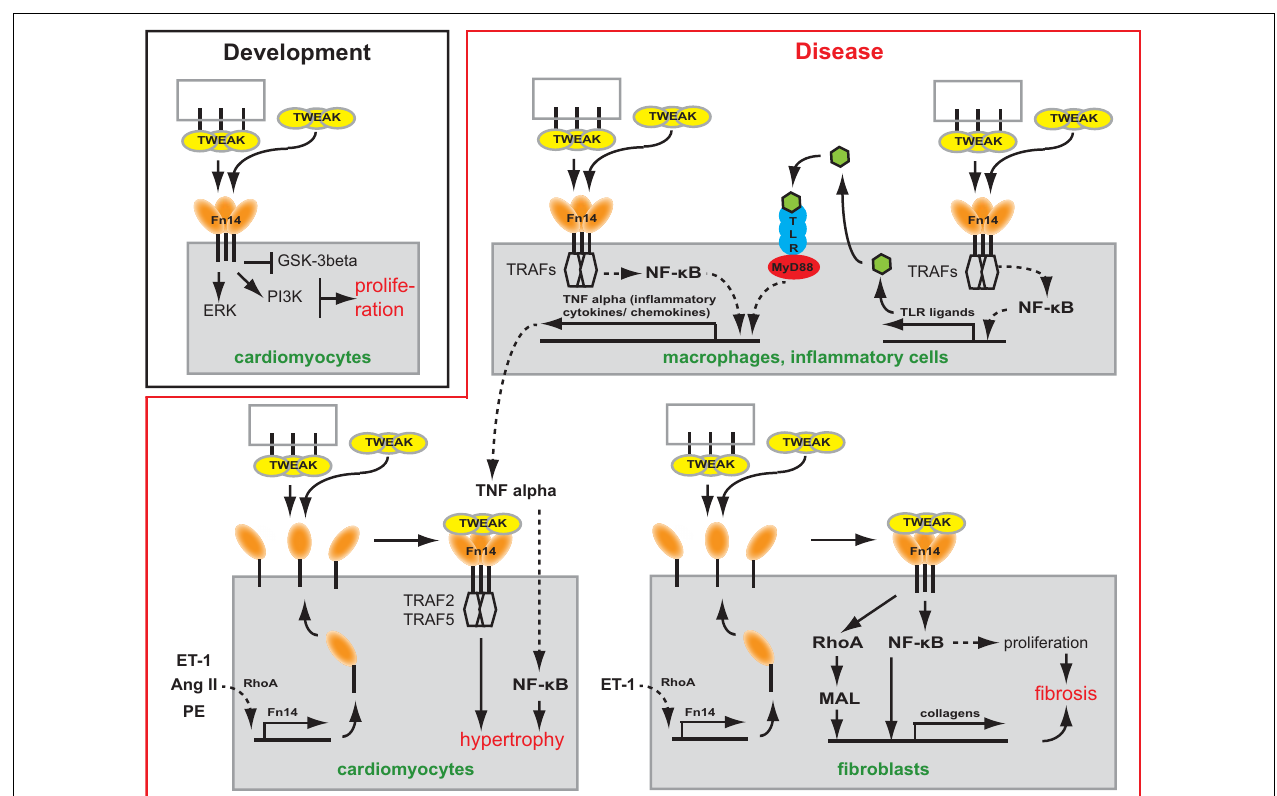
inflammatory cells, cardiomyocytes as well as fibroblasts. In inflammatory cells,TWEAK can enhance secretion of inflammatory cytokines/chemokines by enhancing their expression directly or by increasing the expression ofTLR ligands. In cardiomyocytes,TWEAK induces viaTRAF hypertrophy. In fibroblast,TWEAK induces the expression of collagens via RhoA and NF- κ B and stimulates via NF- κ B proliferation leading to cardiac fibrosis.